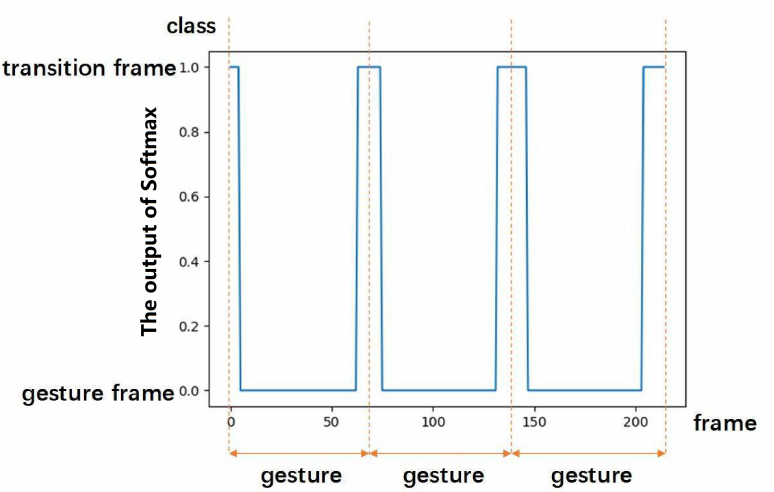
Figure 6. An example of the temporal segmentation results. The transitional frames between adjacent gesture are the boundaries. The sequence is segmented into three isolated gesture sequences, the middle point of transitional frames is defined as the boundary of two